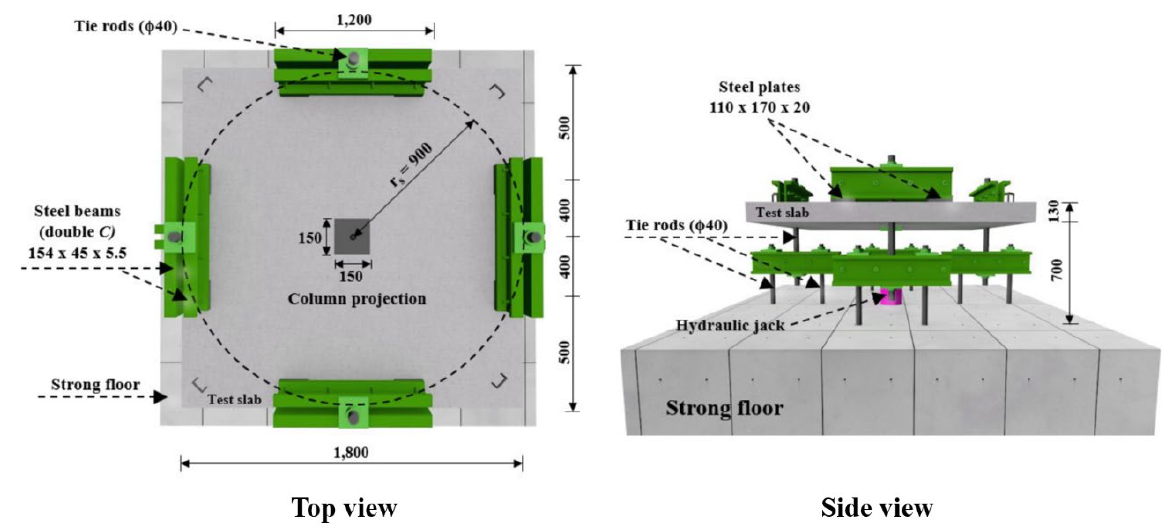
Figure 6. Typical test slabs (units in mm).